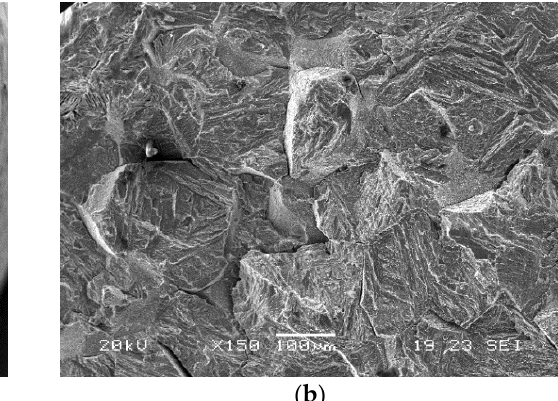
Table 5. Instantaneous strain hardening regression best-fitting parameters, for materials in as- received condition.